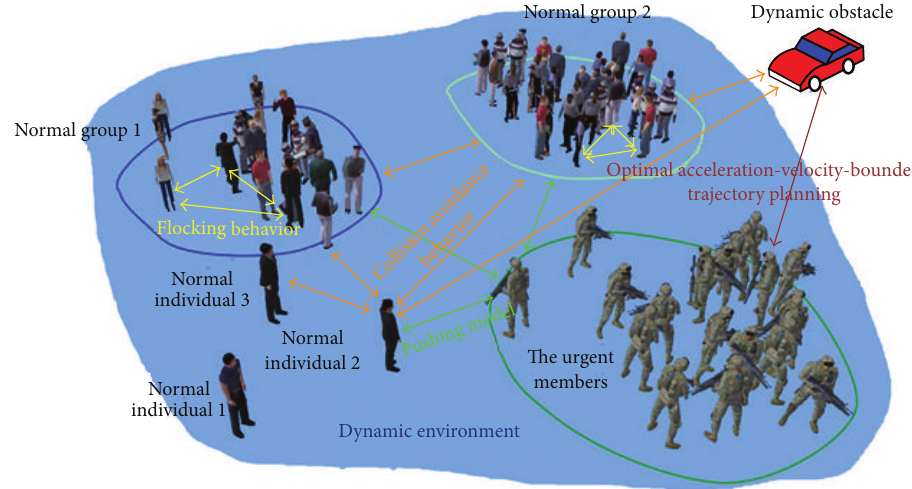
Figure 1: Components of the crowd